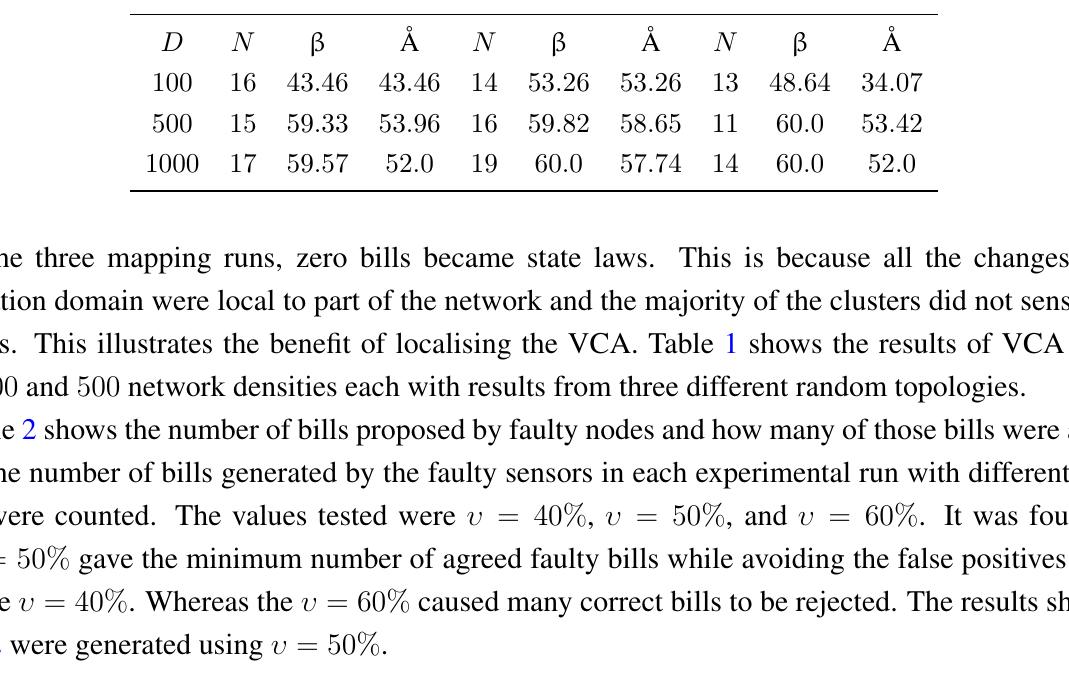
Table 2. The number of bills F proposed by faulty nodes and the number of times they were successfully agreed